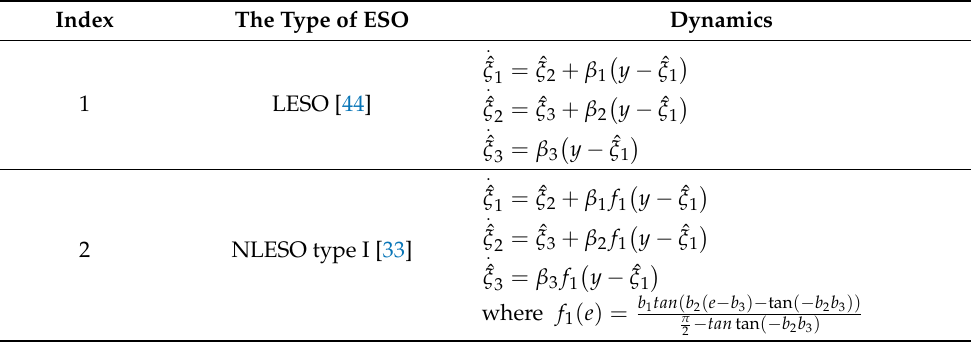
Table 1. The list of the ESOs used in the